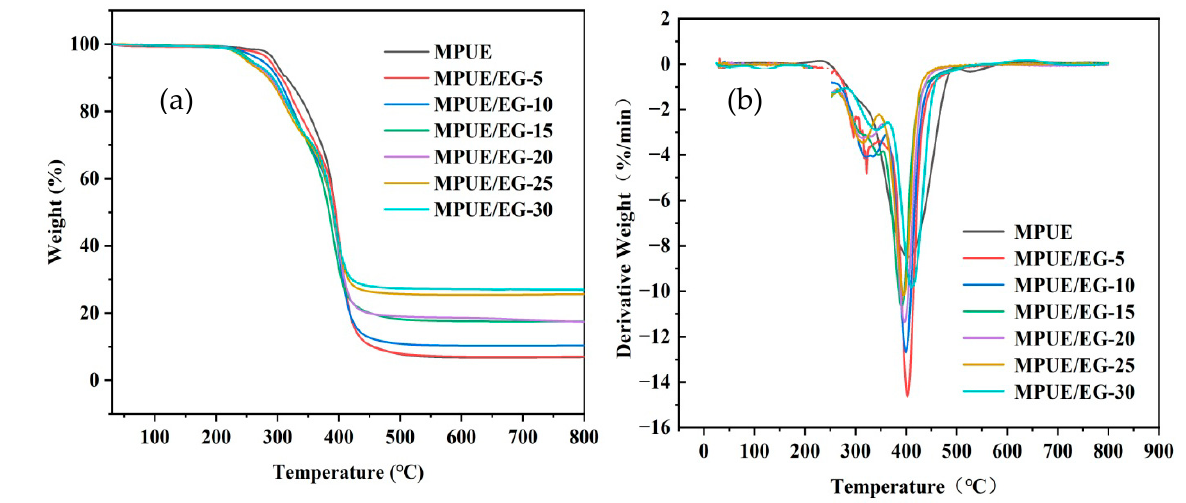
Figure 10. Thermogravimetric analysis (TGA) curves of MPUE/EG ( a ) TGA and ( b ) DTGA. Table 7. Thermogravimetry (TG) data of MPUE/EG.